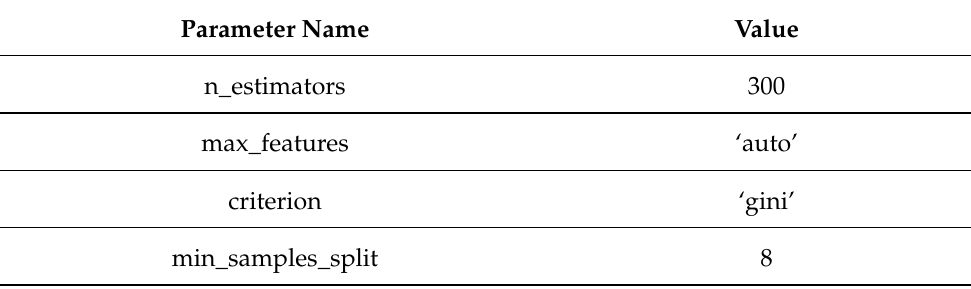
Table 5. Tuned random forest